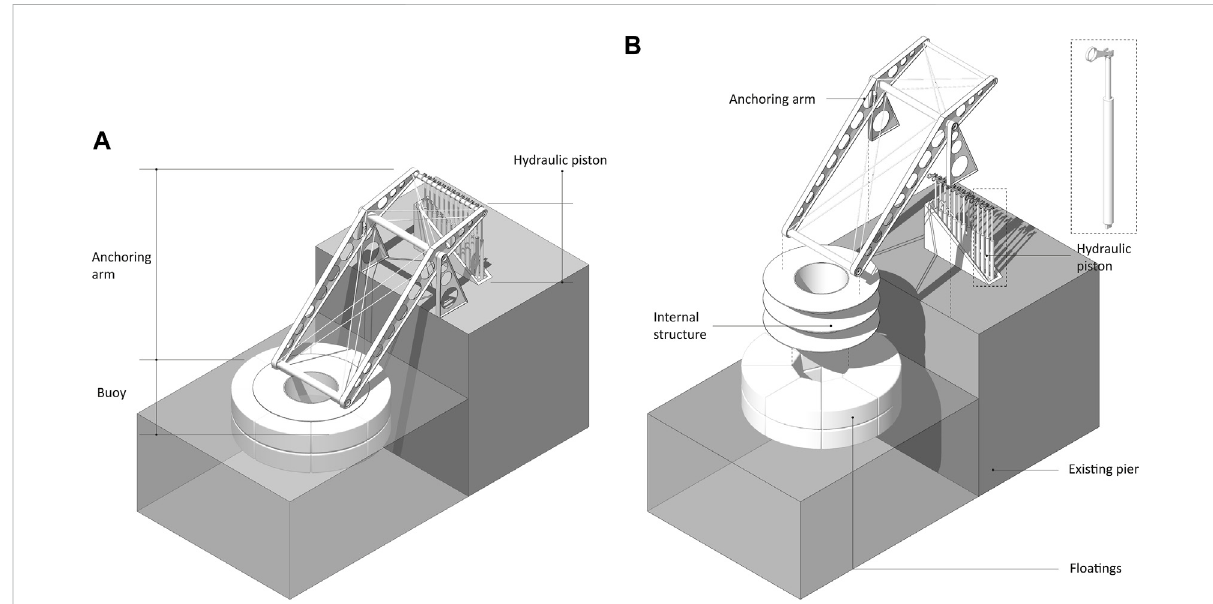
FIGURE 2 The onshore oscillating fl oater 3D model (A) and its main construction elements. (B) Legend and values: buoy diameter = 5 m; anchoring arm height = 6